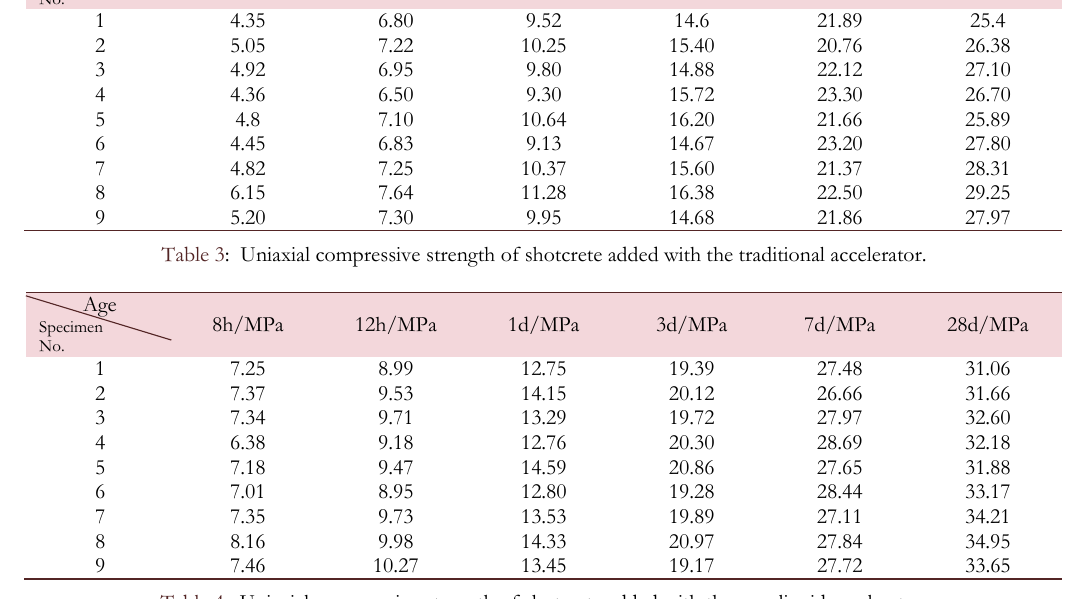
Table 4: Uniaxial compressive strength of shotcrete added with the new liquid